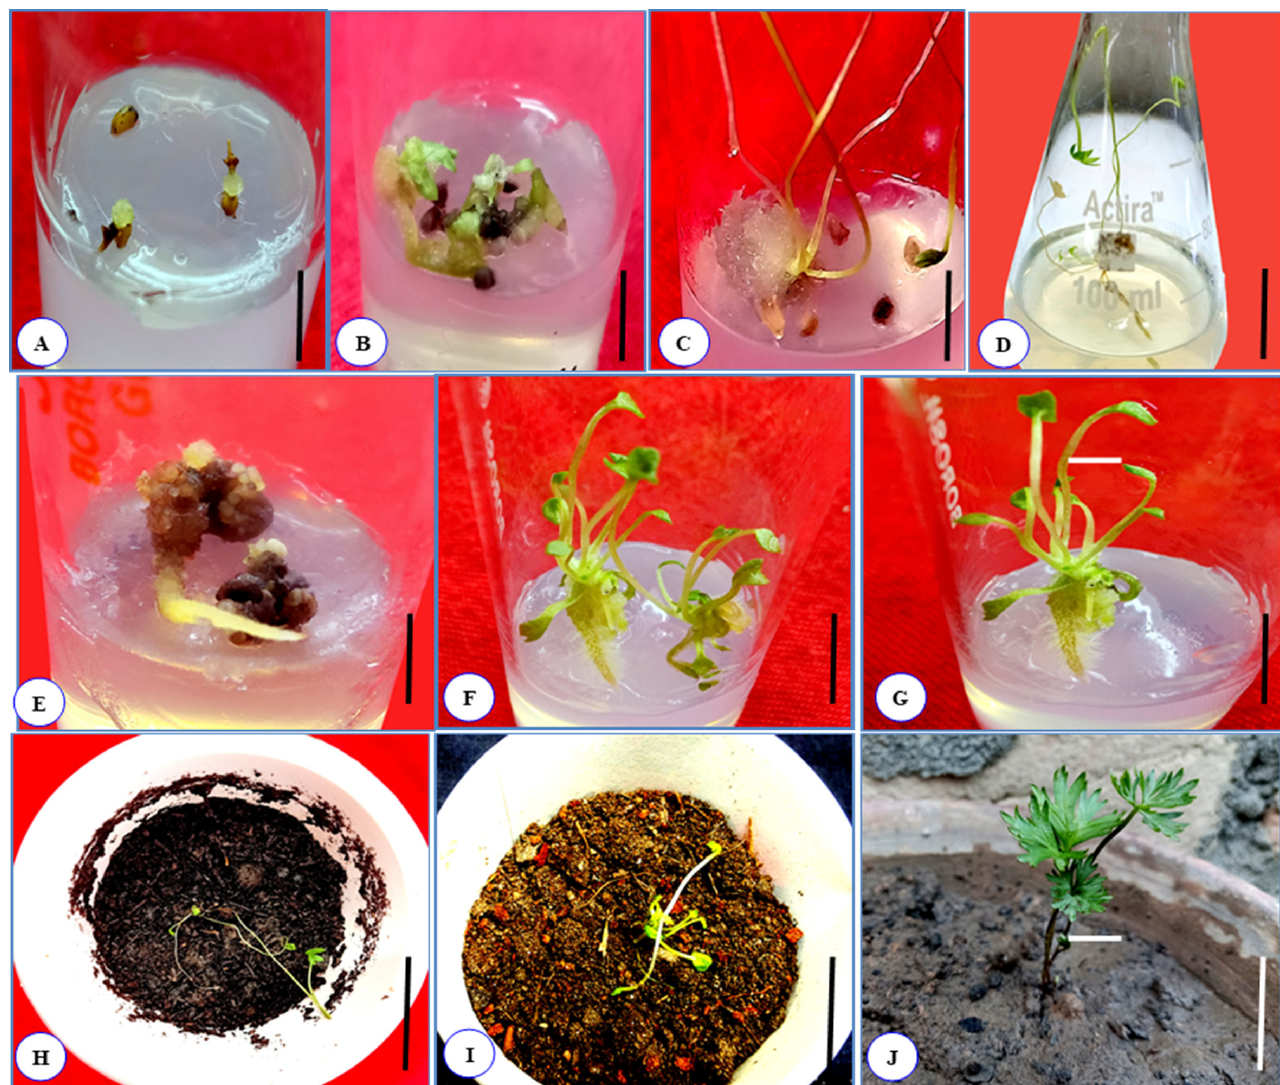
Figure 4. Callus development and plant regeneration from the seeds of Aconitum violaceum in MS basal medium enriched with various concentrations of PGRs, either alone or in combination: ( A